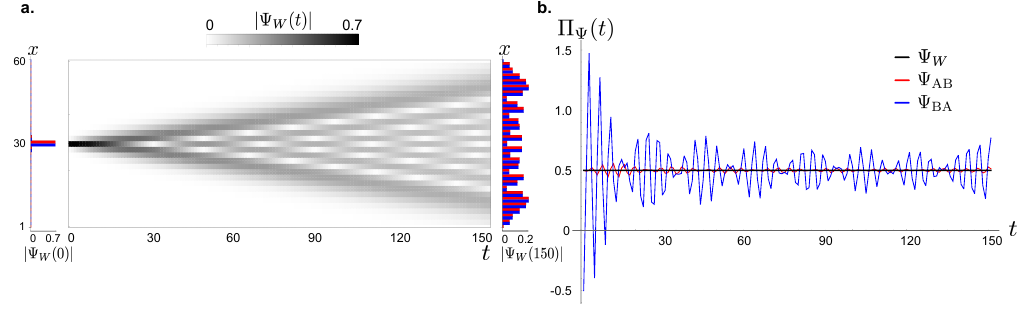
Figure 9: Measuring the chiral polarization in time. a. Left: Dynamical evolu- tion of a Wannier state in the ground state of a two-band SSH model, with hopping / t = 0.1. The state is localized in the middle of a finite system of 60 unit ratio t 1 2 cells. Center: Time evolution of the wave-function amplitude. Right: The amplitude of the final state at time t = 250 is represented on the A (red) and B (blue) sites of the lattice. b. The dynamical chiral polarization Π ψ ( t ) = 〈 Ψ ( t ) | C ˆ X | Ψ ( t ) 〉 cor- responding to the protocol described in a is constant in time (black solid line). By comparison, the dynamical chiral polarization starting from a state Ψ Ψ ( t = 0 ) ), localized on two neighboring sites A and B (resp. B and A ) shows fluc- BA tuations around the static chiral polarization whose amplitude depends on the initial state. The sign Π ψ ( t ) is reversed at short time when the chiral polarization of the initial state is opposite to the static chiral polarization of the SSH chain. This results in large amplitude oscillations. The short time dynamics of Π ψ therefore provides a direct access to the orientation of the material chiral